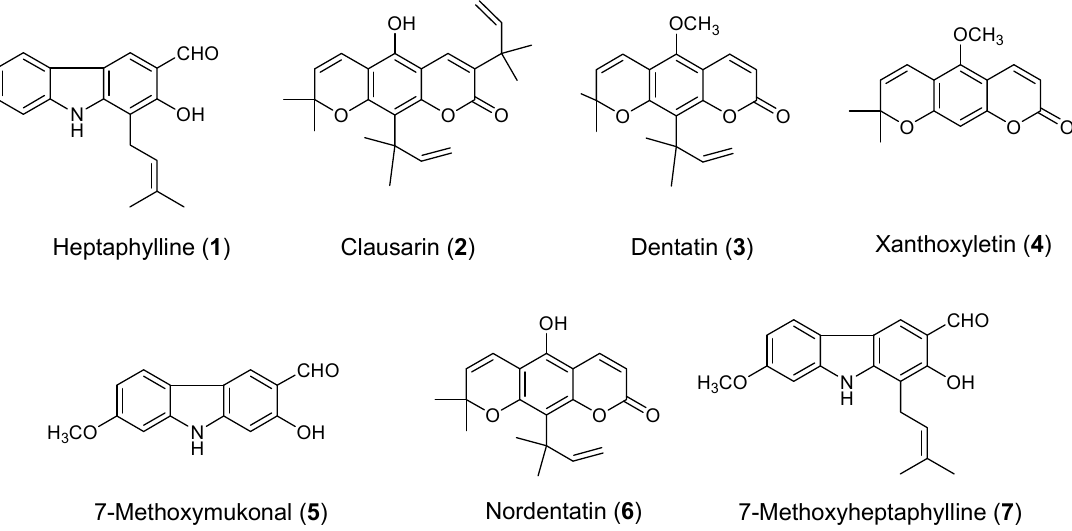
Figure 1. The chemical structures of carbazole alkaloids (1, 5, and 7) and coumarins (2, 3, 4, and 6).